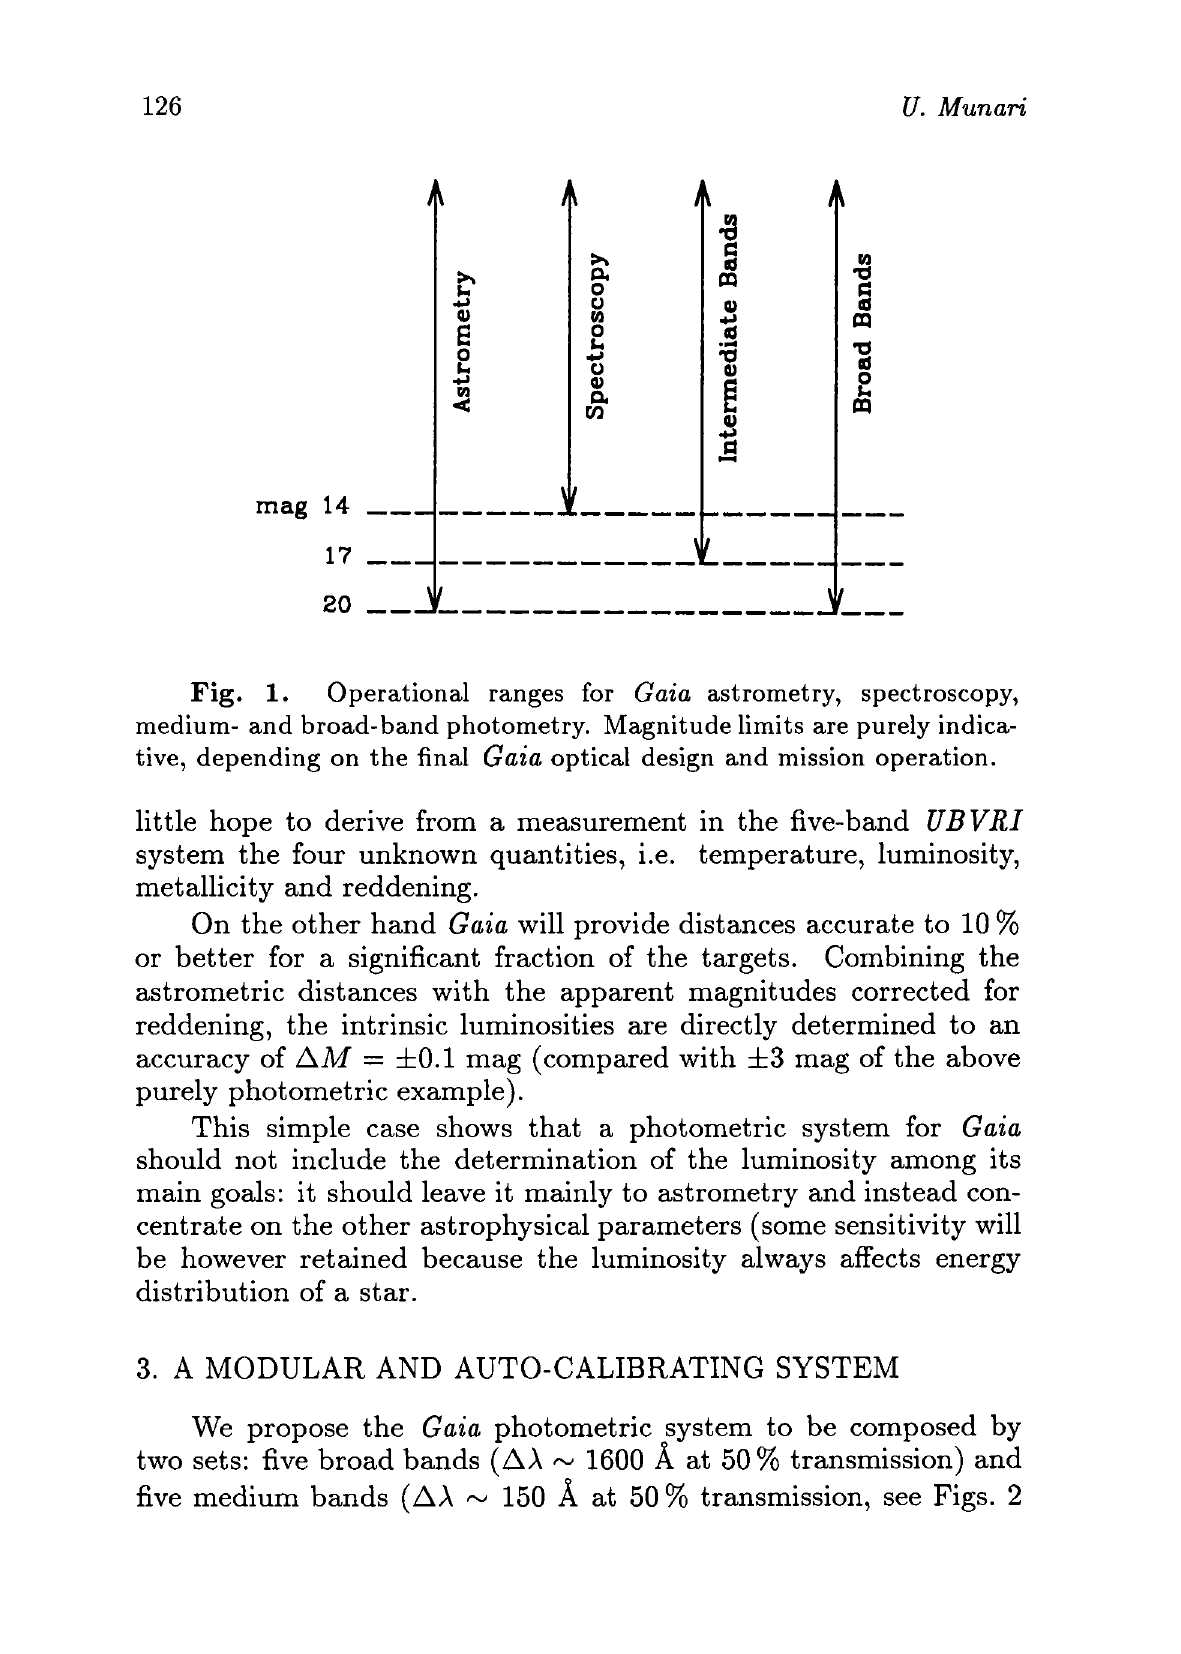
Fig. 1. Operational ranges for Gaia astrometry, spectroscopy,